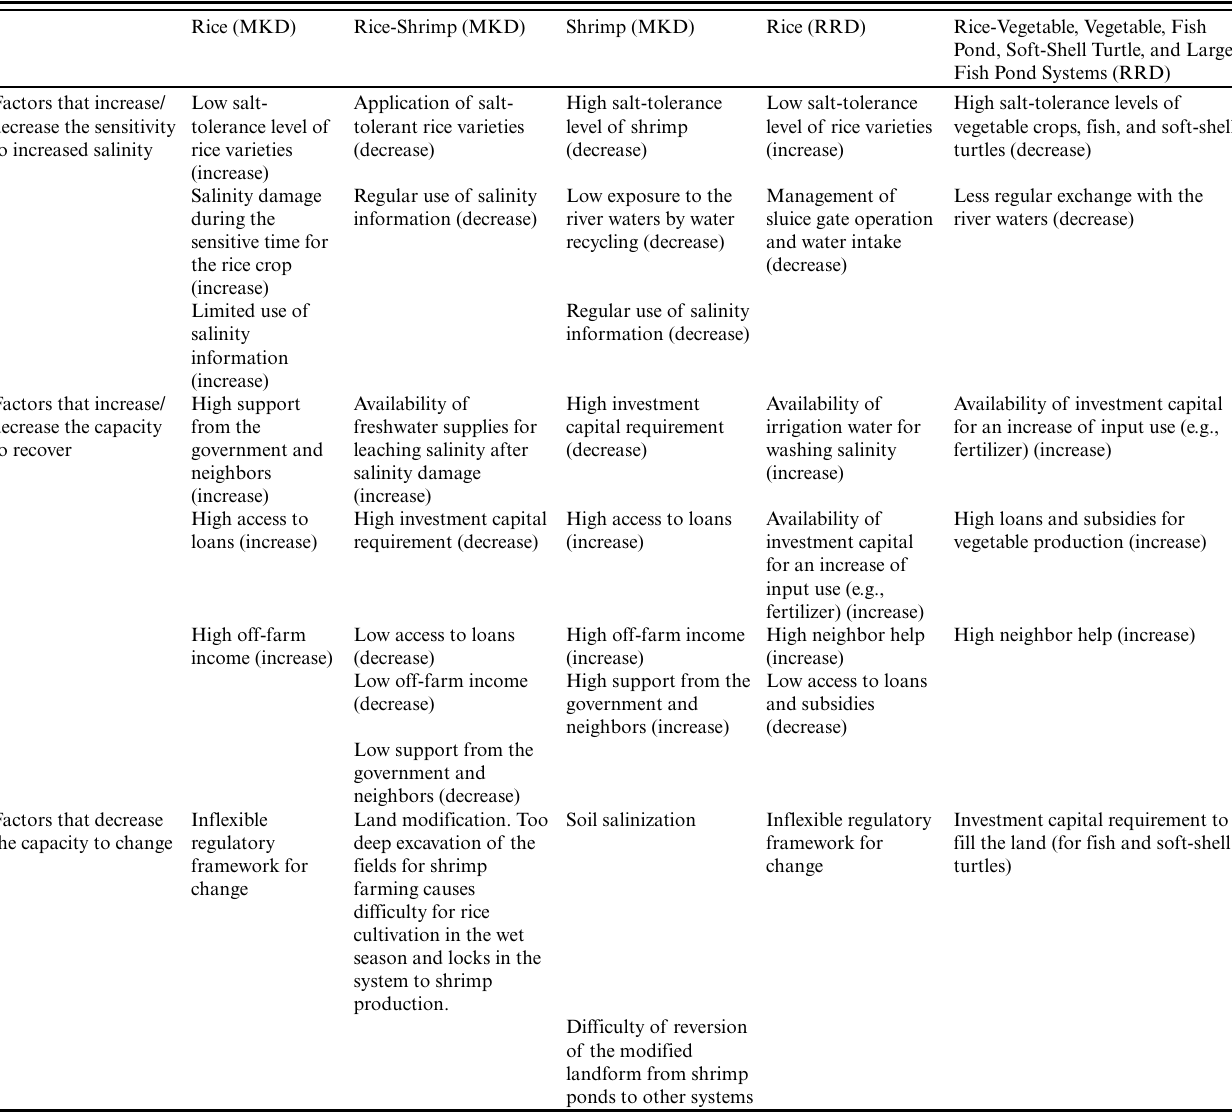
Table 7 . Factors that characterize the resilience components of agricultural systems. MKD, Mekong Delta; RRD, Red River